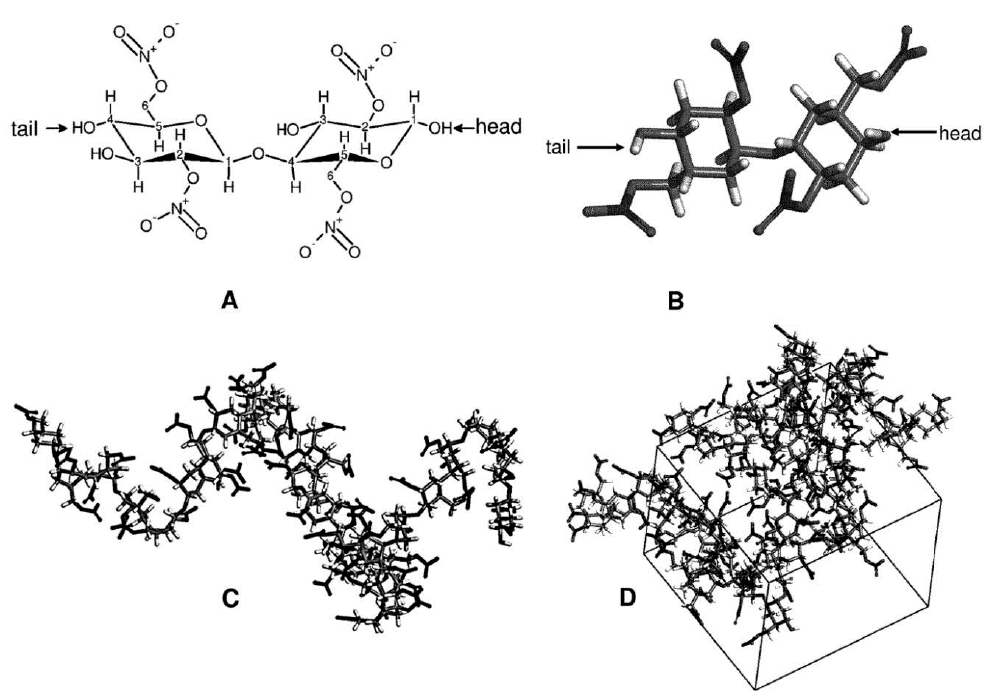
Figure 7. ( A ) the 2,6-dinitroester-pyranose disaccharide of nitrocellulose that was used to simulate the nitroester with a degree of substitution of 2 (the carbon atoms are denoted by numbers). Head-to-tail addition was performed for polymer formation. The β -D(1 → 4) glycosidic bond is also shown in the disaccharide structure. ( B ) the geometrically optimized structure of the disaccharide repeat unit, ( C ) an example of a geometrically optimized 30 mer chain and ( D ) a periodic simulation box packed with 10 mer chains.